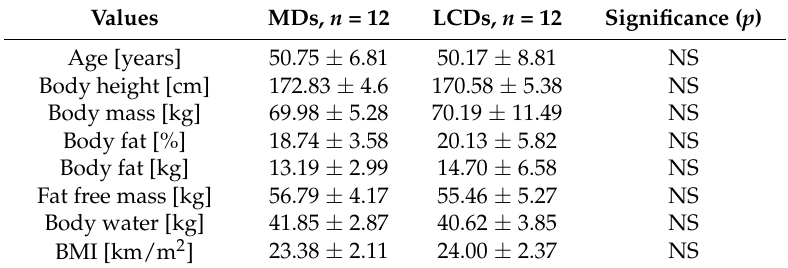
Table 1. Somatic characteristics of participants in the low carbohydrate diets (LCDs) and mixed diets (MDs) groups.